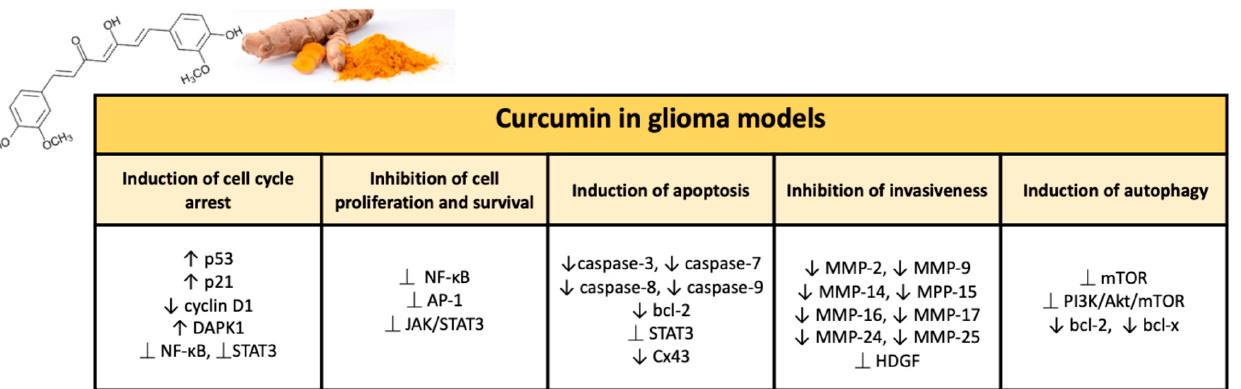
Figure 2. Major effects of curcumin on glioma models in preclinical studies. Inhibition of Cell Proliferation and Survival